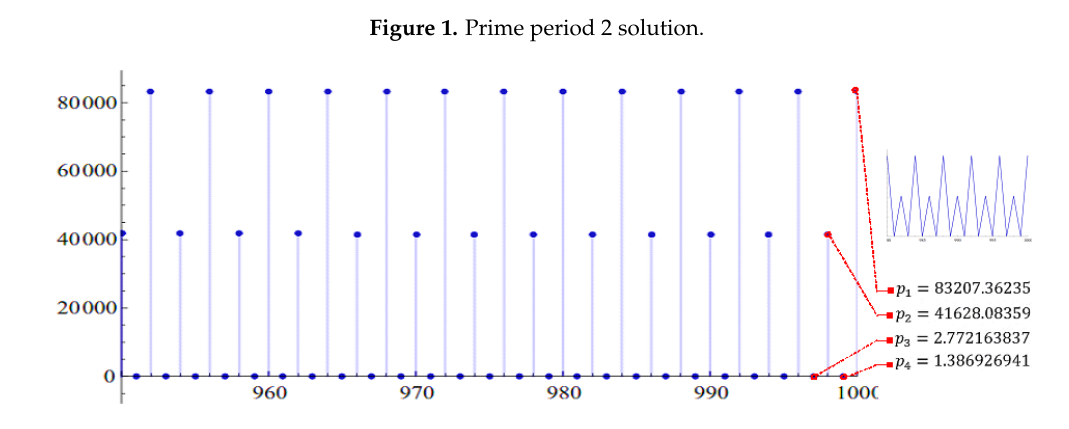
Figure 2. Prime period 4 solution.